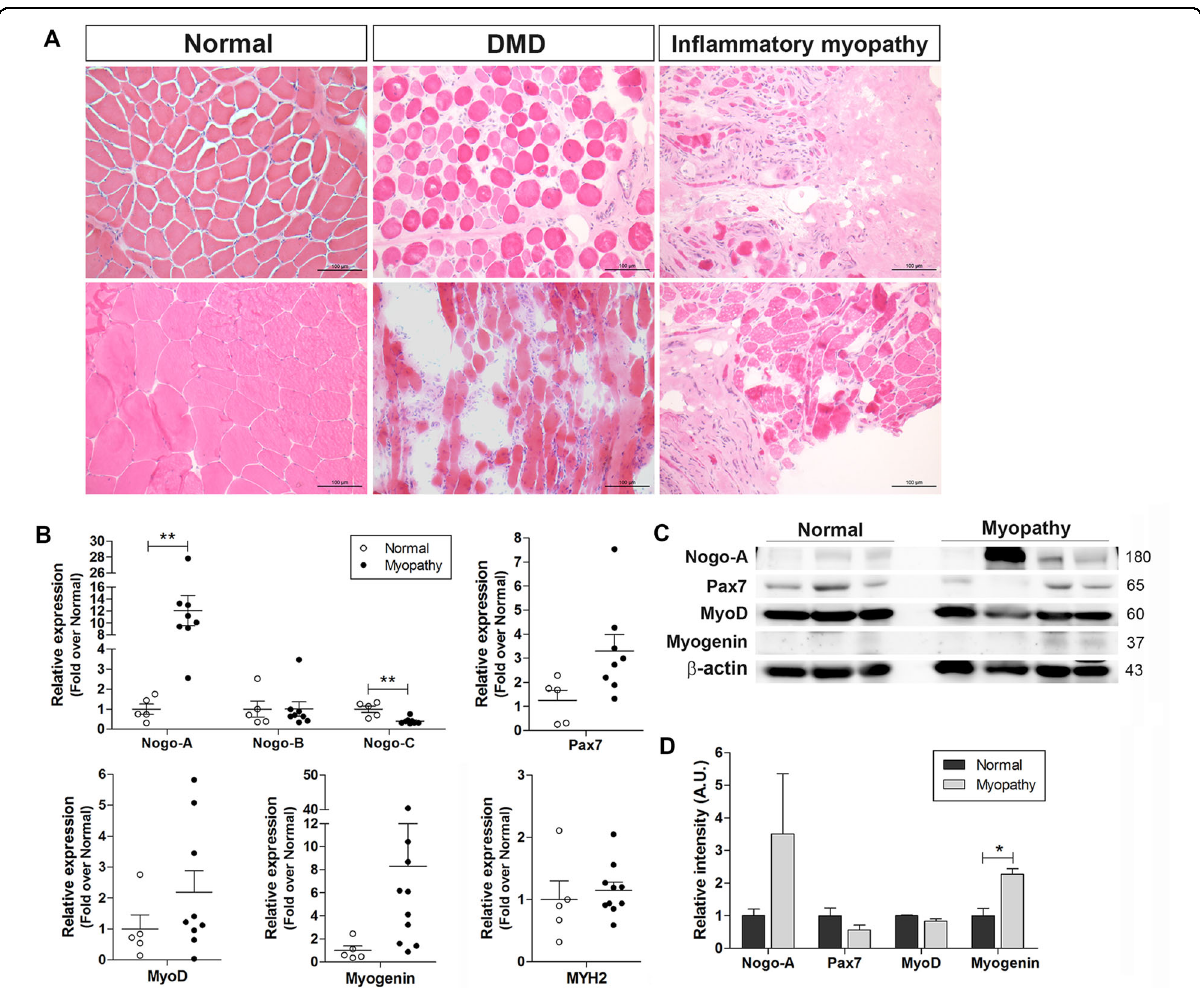
Fig. 1 Altered expression of Nogo and myogenic factors in muscles under pathological or abnormal physiological states. A Hematoxylin/ eosin staining of muscle biopsy samples from patients with Duchenne muscular dystrophy (DMD) and in fl ammatory myopathies and normal subjects. Scale bar = 100 µm. B Muscle mRNA samples from normal human subjects ( n = 5) and patients with myopathy ( n = 8 – 10) were evaluated by quantitative reverse-transcription PCR (qRT-PCR). Mean ± SEM. ** p < 0.01. C Western blot (WB) analysis of indicated proteins in muscles tissue samples from normal subjects ( n = 3) and myopathic patients ( n = 4). Molecular weights (kDa) are indicated. D Quantitative assessment of band intensity ( C ) using the NIH ImageJ software. Mean ± SEM. * p <